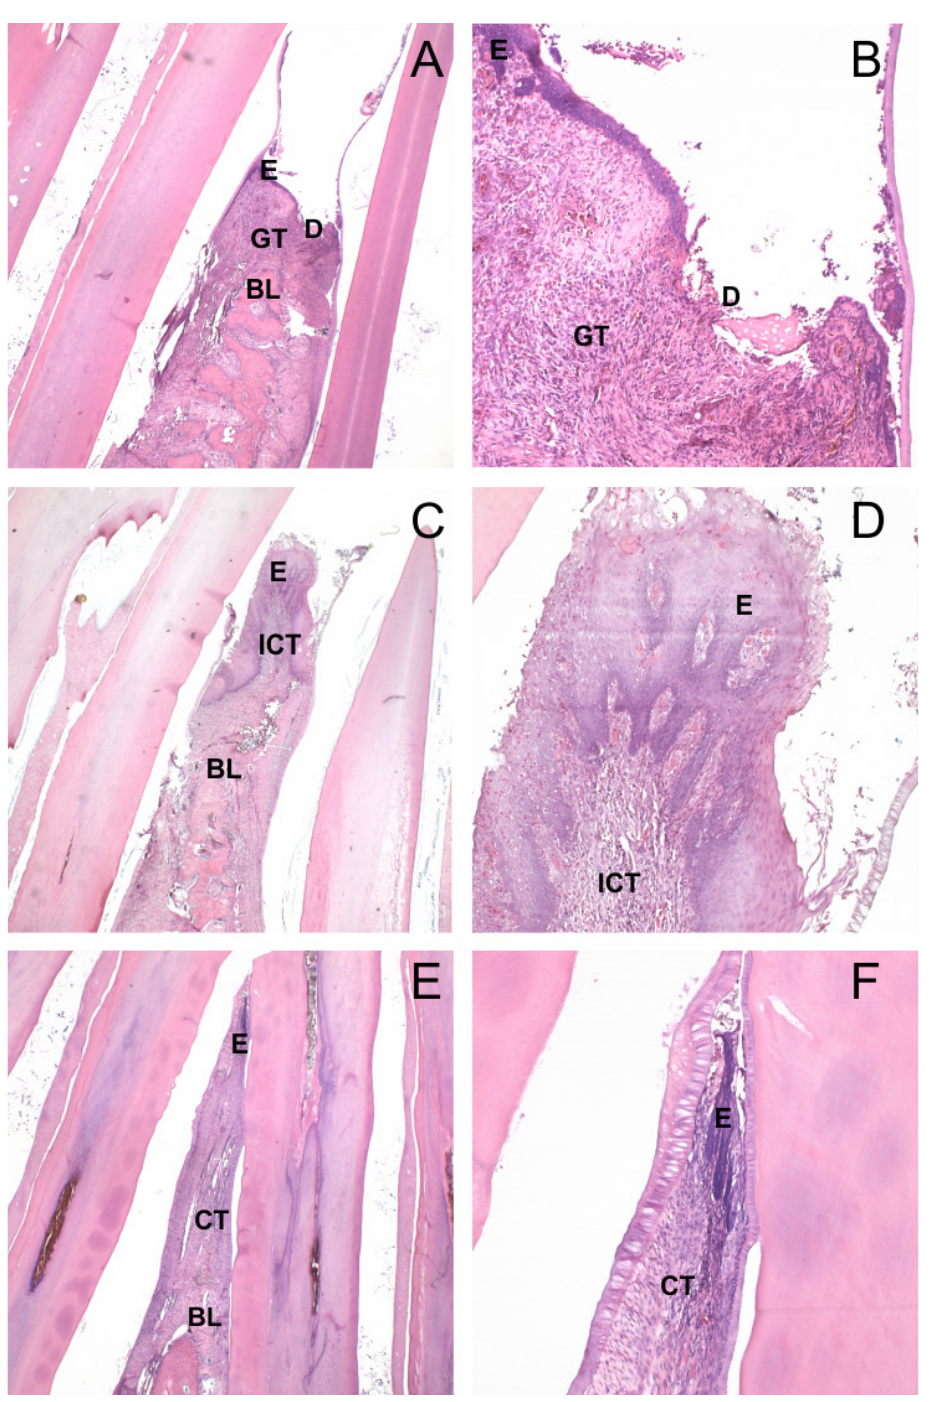
Fig. 5. Defect healing stages and histological characteristics. At 2 weeks (A,B), 6 weeks (C,D), and 12 weeks (E,F) after surgery (H&E, original magnification x20 (A,C,E), and x100 (B,D,F). (A,B) Two weeks after surgery, the defect persists, with epitheli- alization only observed at its periphery, and dense mixed inflammatory infiltrate is present at the base of the wound and within the highly cellular granulation tissue. (C,D) Six weeks after surgery, the defect is epithelialized, with moderate to intense mixed inflammatory infiltrates within the epithelium and the underlying highly cellular immature connective tissue, and proliferation of fibroblasts and capillaries is observed. (E,F) Twelve weeks after surgery, the defect is completely epithelialized, with minimal subepithelial inflammatory infiltrate, and mature fibrous tissue is present in the interdental area. E: epithelium; D: defect; GT: granulation tissue; ICT: immature connective tissue; CT: connective tissue; BL: bone